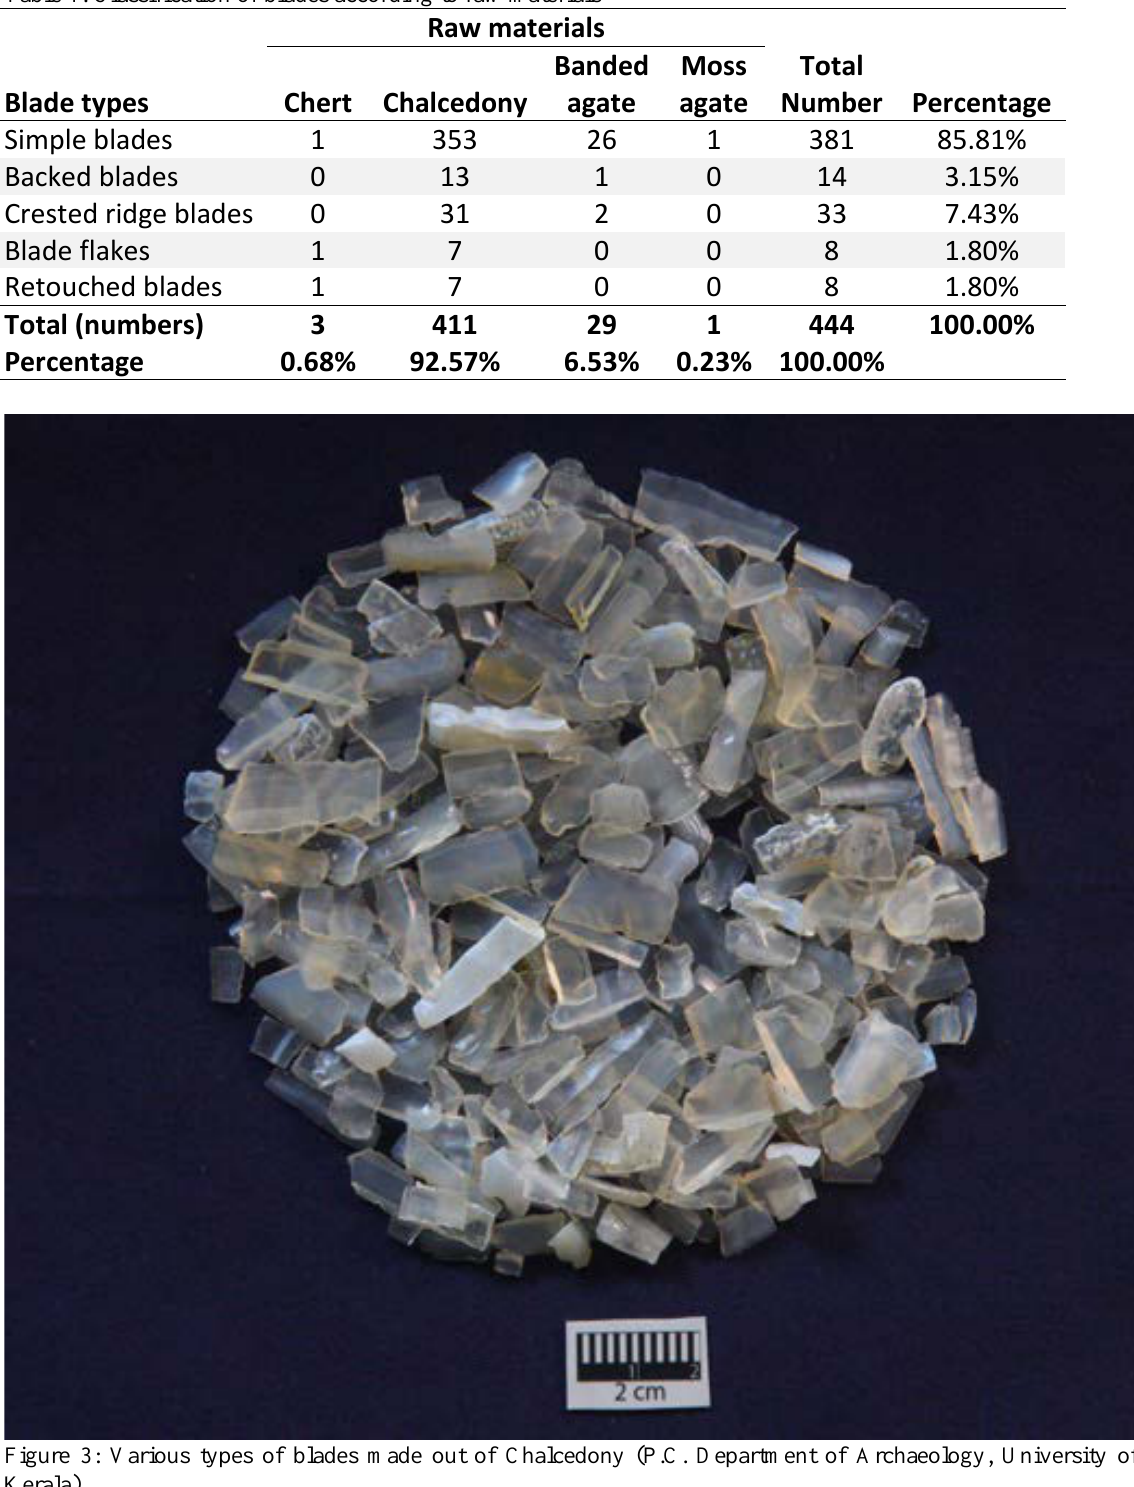
Table 1: Classification of blades according to raw materials